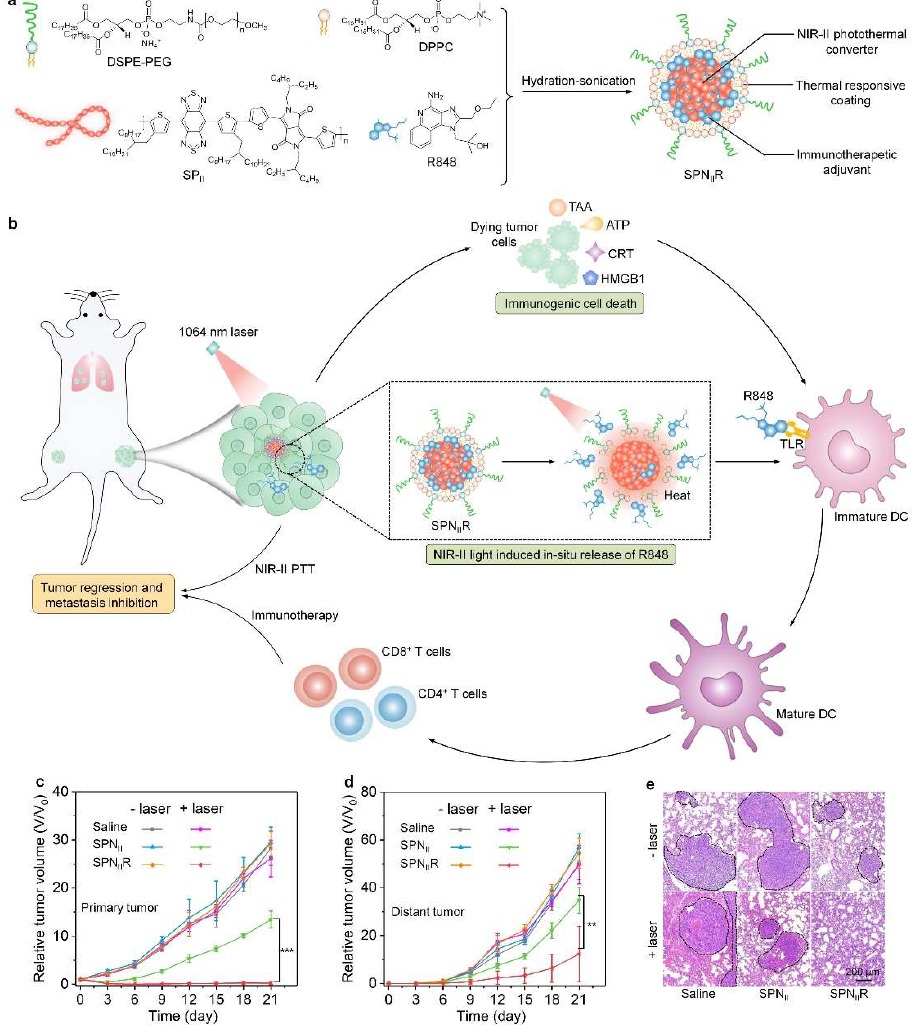
Figure 2. ( a ) The chemical structures of DSPE-PEG, DPPC, SP II , and R848, and the synthesis of SPN II R. ( b ) A schematic illustration of the mechanism of SPN II R for NIR-II synergetic photothermal immunotherapy. ( c ) The relative tumor volumes of the primary tumors from 4T1 tumor-bearing BALB/c mice after the systemic administration of saline, SPN II , or SPN II R through tail-vein injection with or without laser irradiation at 1064 nm. ( d ) The relative tumor volumes of distant tumors from 4T1 tumor-bearing BALB/c mice after different treatments. ( e ) Hematoxylin and eosin (H&E) staining images of lung metastasis from mice after different treatments for 21 days. Reproduced with permission from [61]. Copyright 2021, Wiley-VCH. Data are expressed as mean ± SD, ** p < 0.01, *** p <